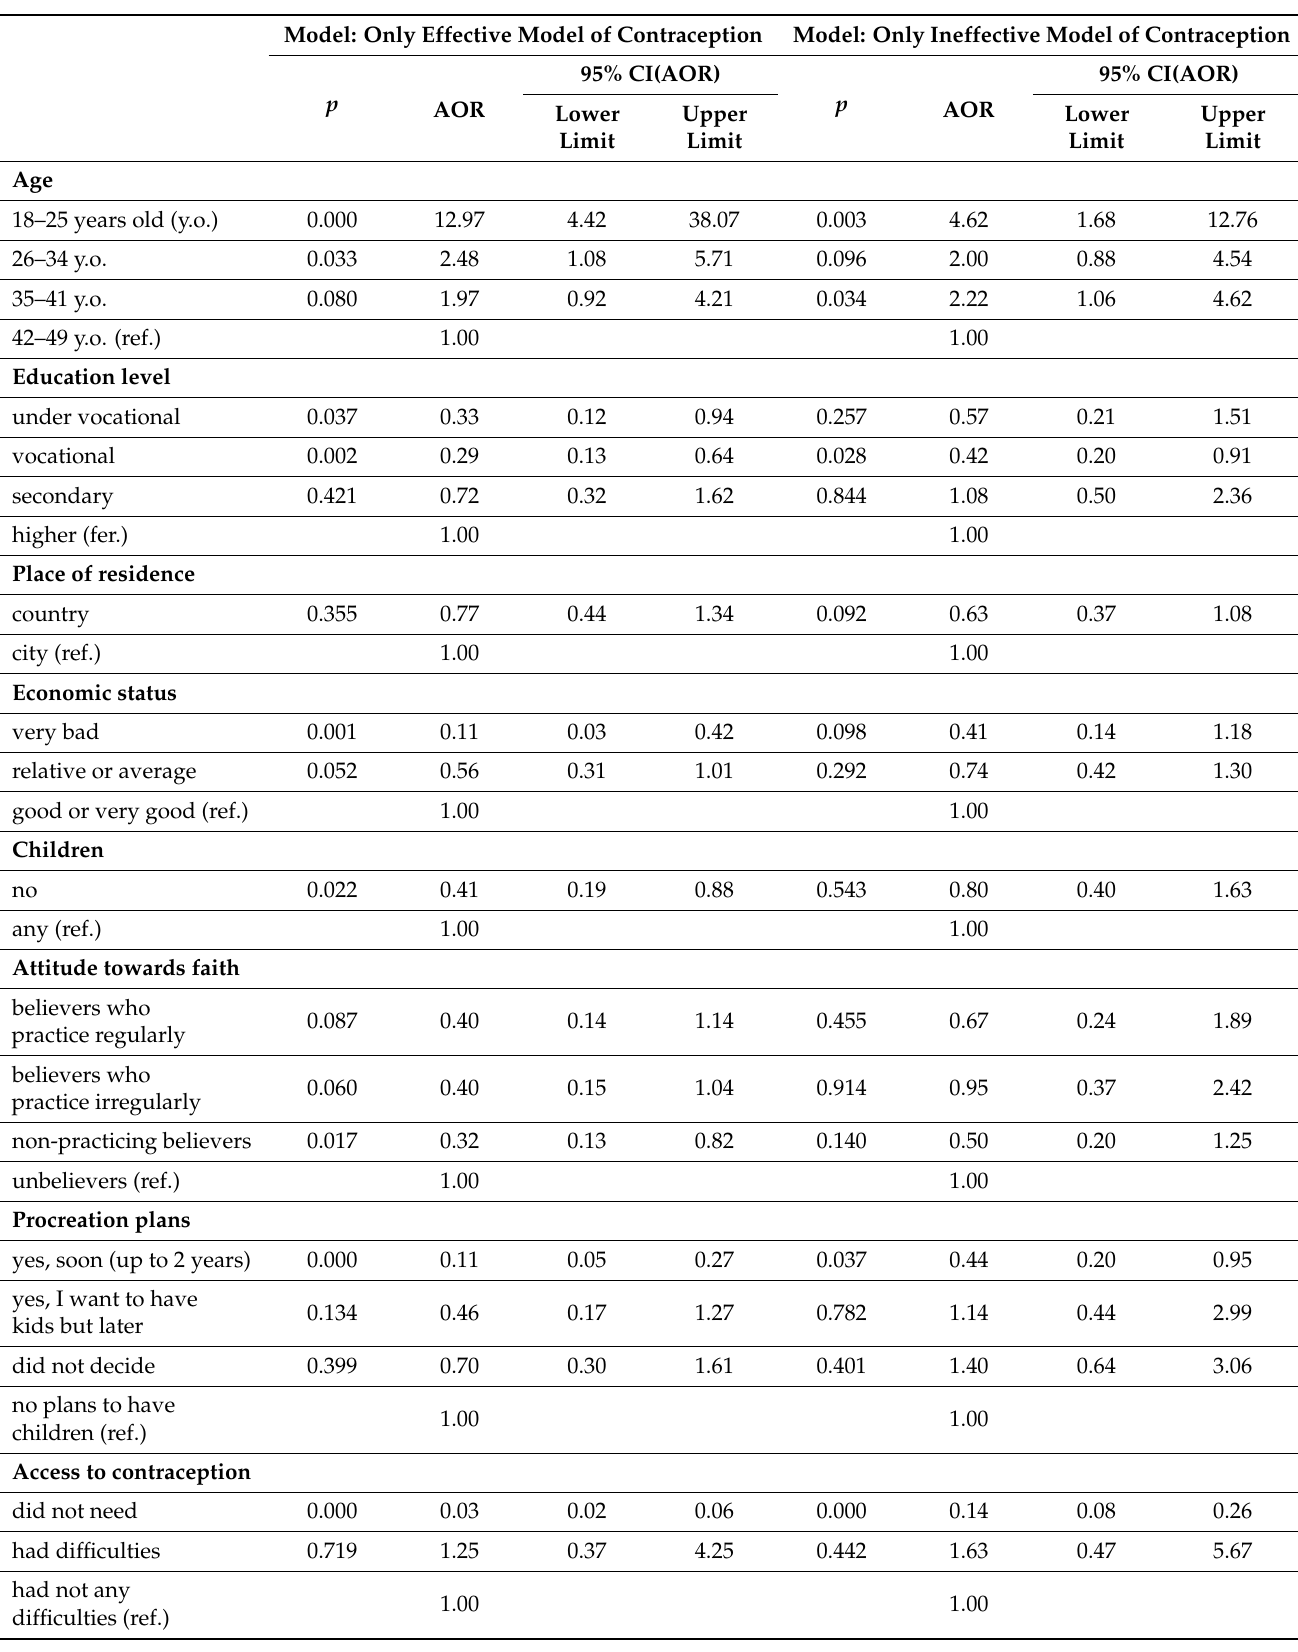
Table 4. Estimation results of polynomial logistic regression